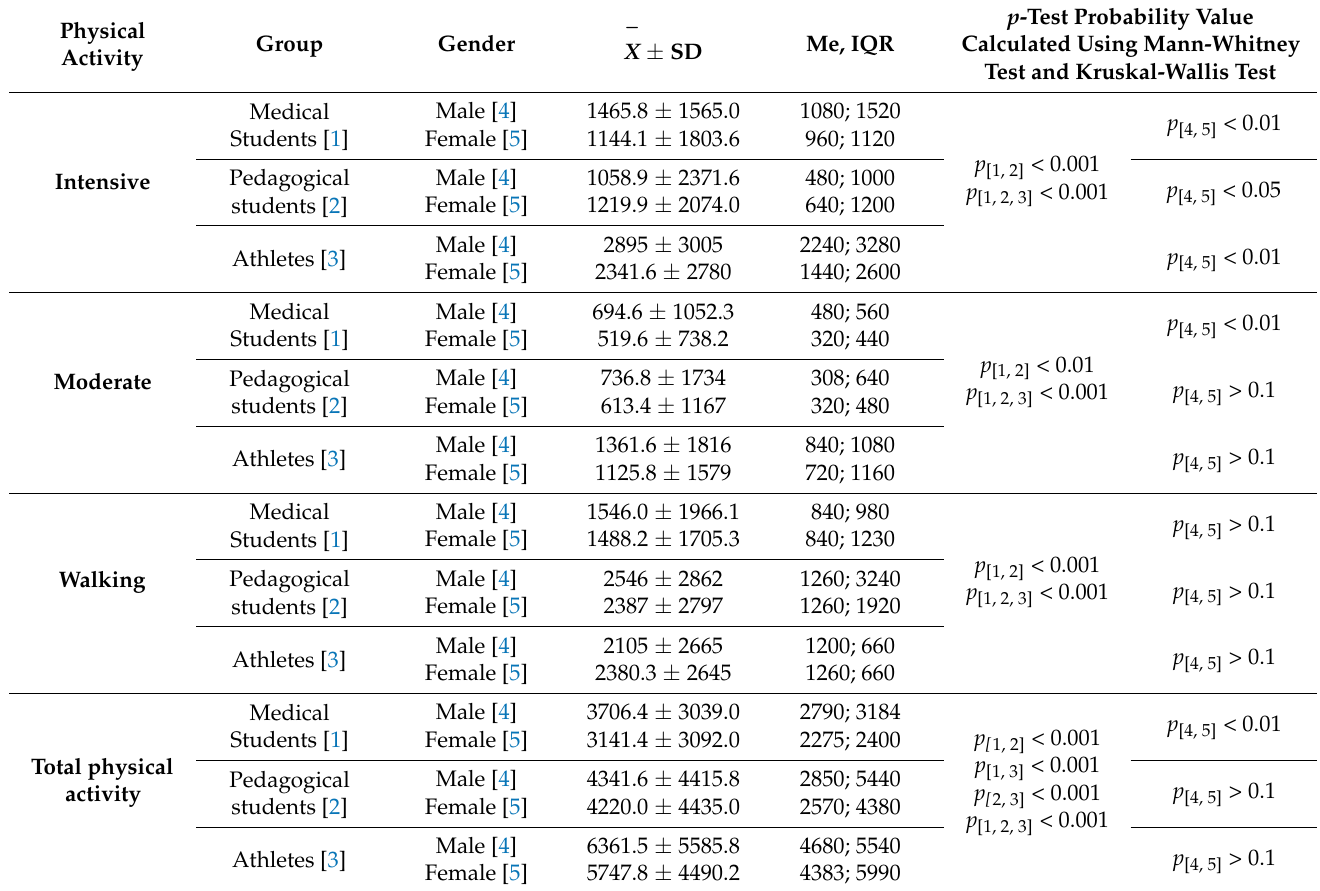
Table 2. Descriptive statistics of the main types of PA of Belarusian